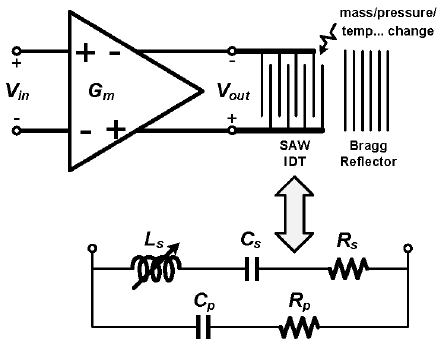
Figure 1. Equivalent circuit model of a one-port SAW device ( G m represents the input driver of the SAW IDT, the RLC model of the SAW IDT is shown in the lower part).